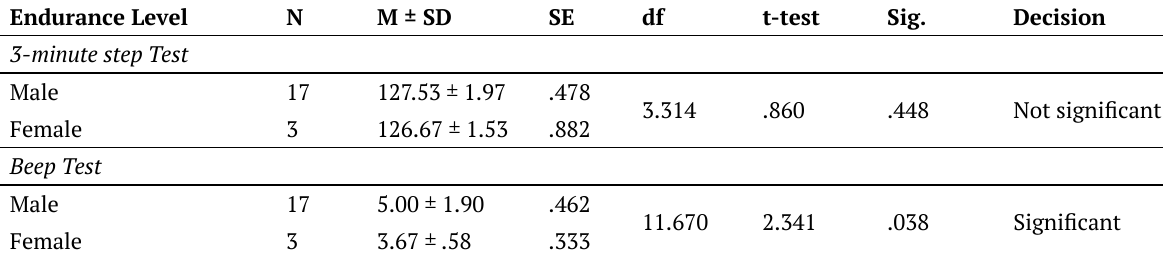
Table 5. Age and Body Mass Index in terms of Endurance